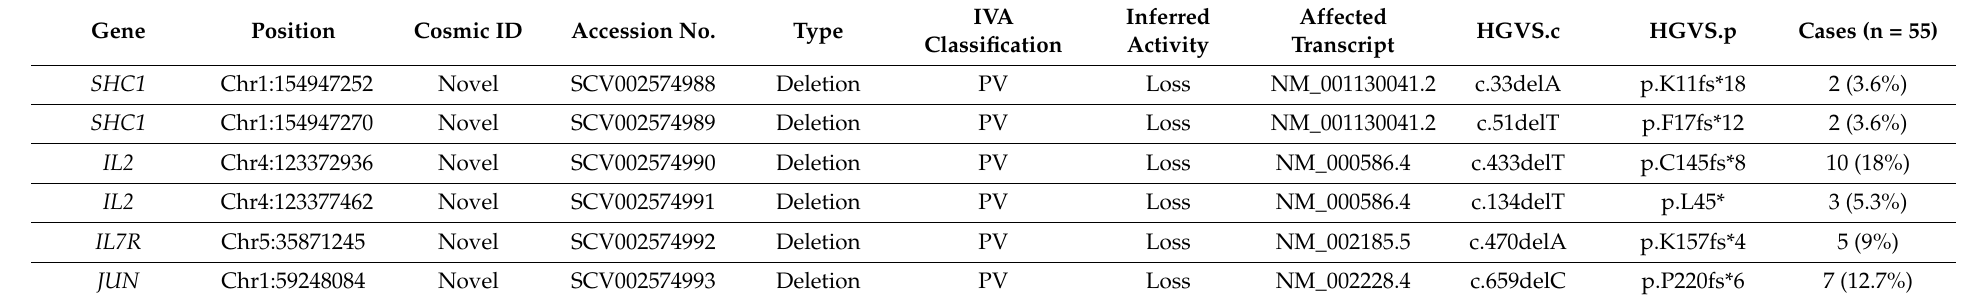
Table 3. Novel mutations identified in our multigene panel